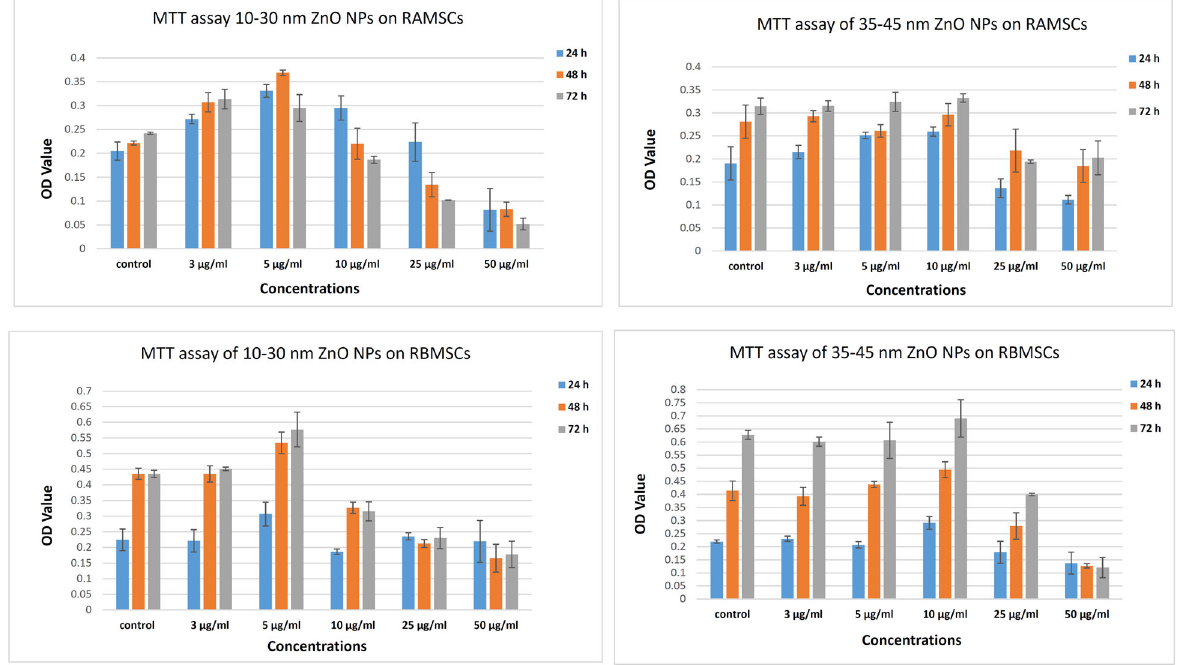
Fig. 3 Effects of ZnO NPs on the viability of AMSCs and BMSCs, determined by MTT assay after 1, 2, and 3 days incubation with ~10 – 30 and 35 – 45 ZnO NPs in comparison to the control group. Optimum OD of cells treated with 10 – 30 ZnO NPs was obtained at